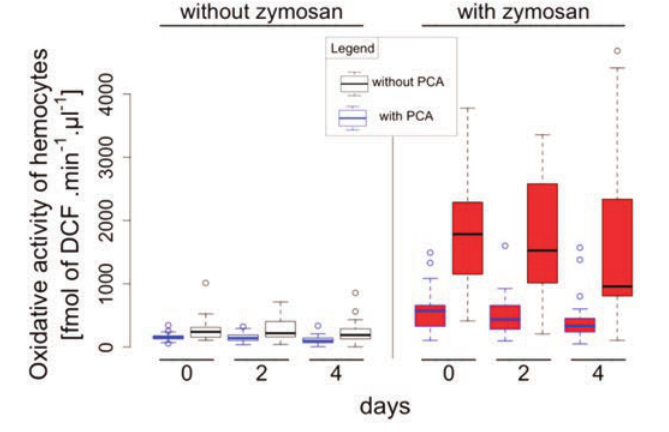
Figure 1. Hemocyte-related oxidative activities under repeated hemolymph collections. The graph represents the oxidative activity from snail’s hemocytes - being sampled every 48 h - under different ex vivo conditions. The ex vivo conditions correspond to samples with zymosan (right) and without zymosan (left); both groups were supplemented with PCA (blue borders) or not (black borders).